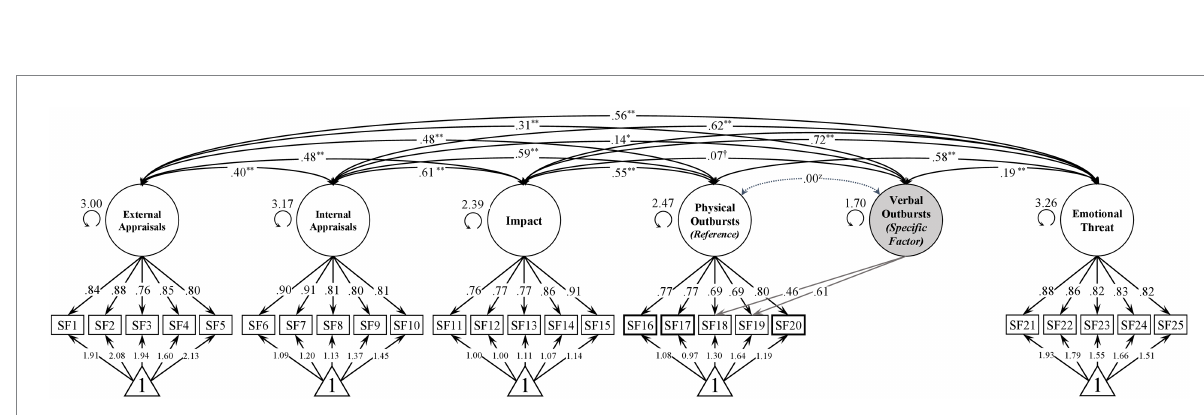
FIGURE 3 Bifactor S-1 Model of S-Five Scales. N = 639. Factor loadings and intercepts are completely standardized (both latent and observed variables). Unstandardized factor standard deviations are shown next to the latent variables. z The correlation is per definition set to zero. † n.s., * p < 0.05, ** p <